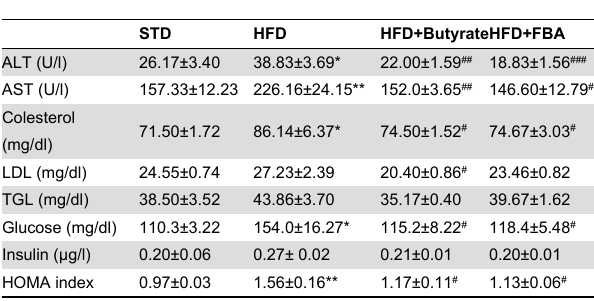
Table 1. Changes in serum parameters of rats fed with control standard diet (STD), high fat diet (HFD) or high fat diet and treated with Butyrate or FBA for 6 weeks.